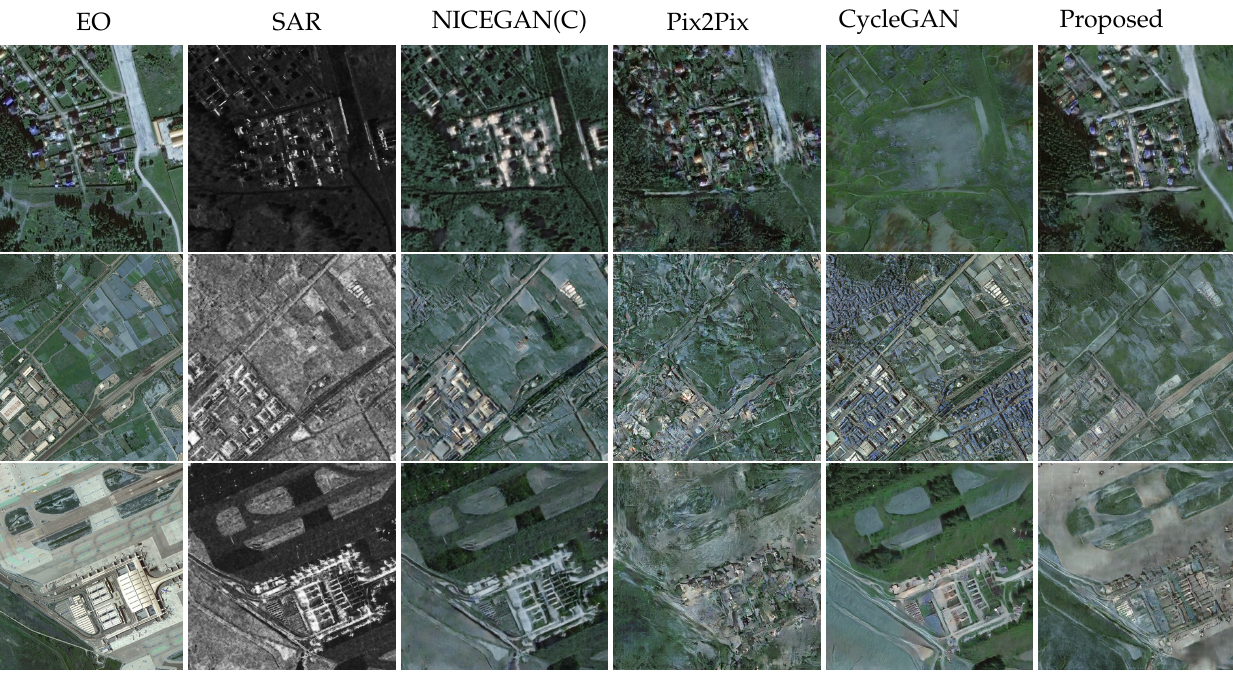
Figure 10. Visual samples of different methods for the S2E translation task on the SAR2Opt